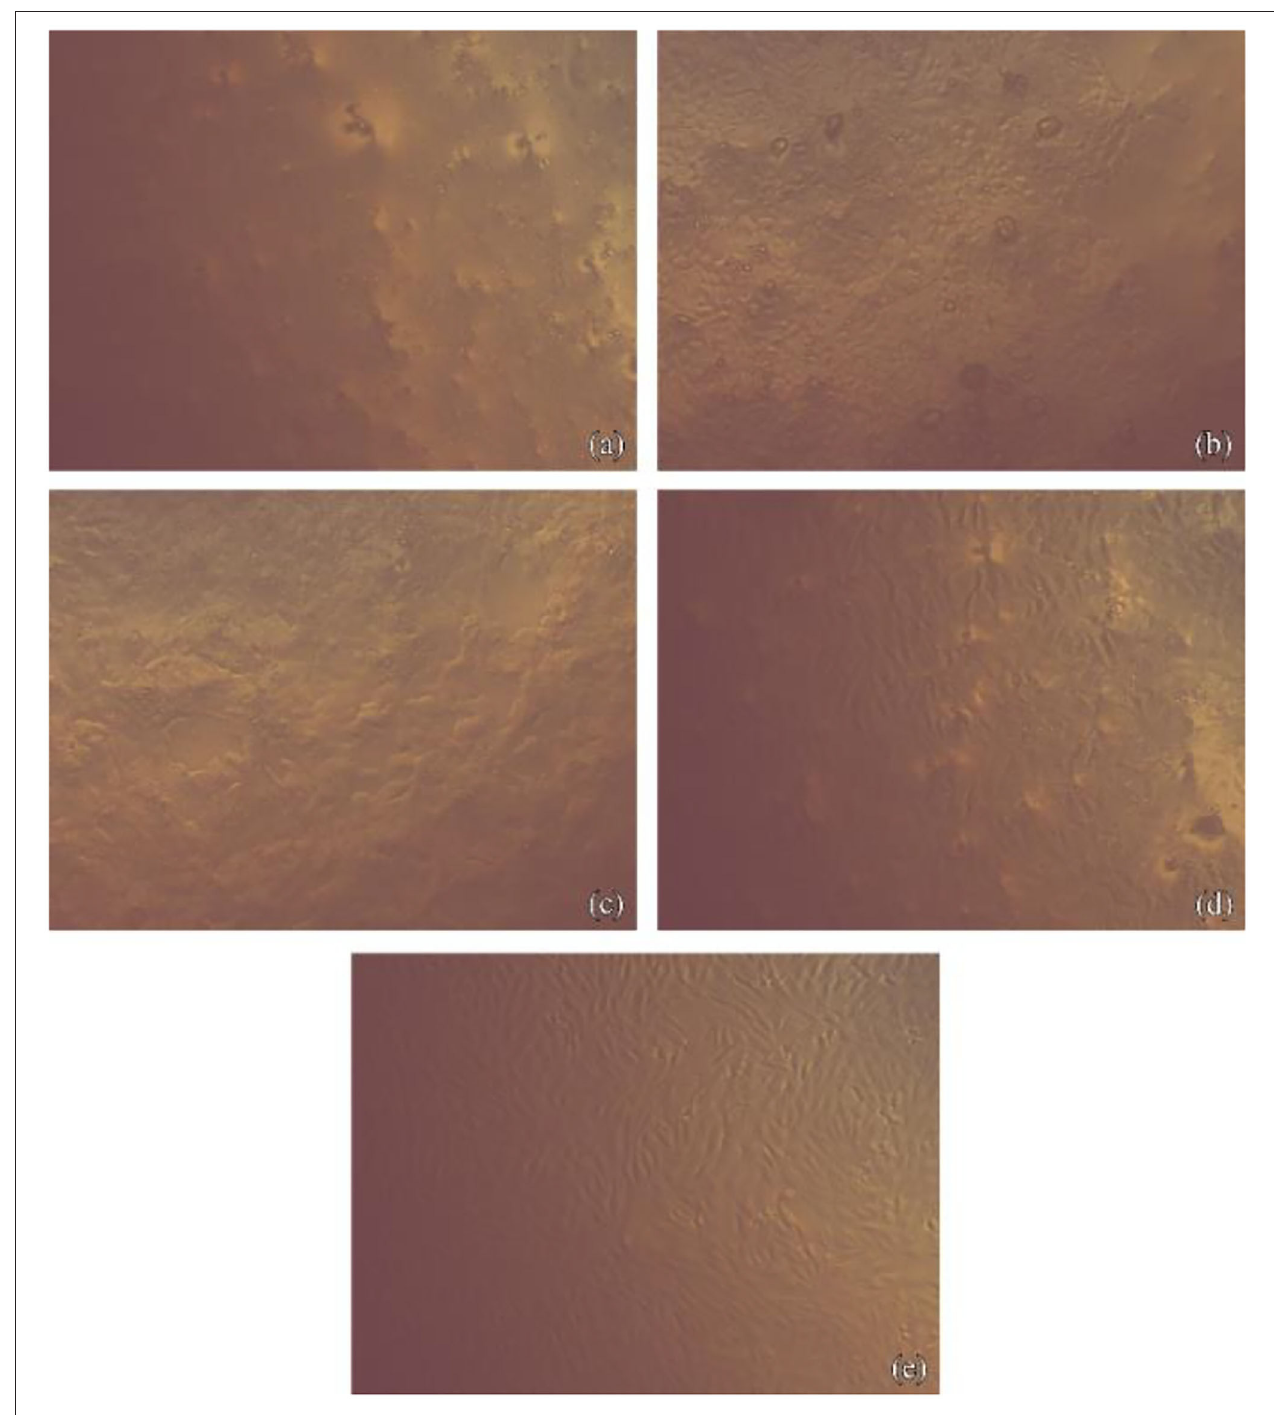
FIGURE 1 | Fibroblasts cells imaged with phase-contrast microscope showing their morphology after contact with NHA-SPS suspension. (a) For 1h at concentration 10 gm/ml, Images show lowest cell density with loss of normal spindle morphology. About 50% of cells became rounded, no granules in the cytoplasm. Cell lysis and empty spaces show between cells. (b) For 1h at concentration 2.5 gm/ml, images show little spindle cells shrunk, separating from the substrate and visible intraplasmic granules. (c) For 5min at concentration 10 gm/ml, images show lowest cell density with the loss of normal spindle morphology. About 50% of cells became rounded, no granules in the cytoplasm. Cell lysis and empty spaces show between cells. (d) For 5min at concentration 2.5 gm/ml, images show little spindle cells shrunk, separating from the substrate, and visible intraplasmic granules. (e) Normal fibroblast cells as a control.